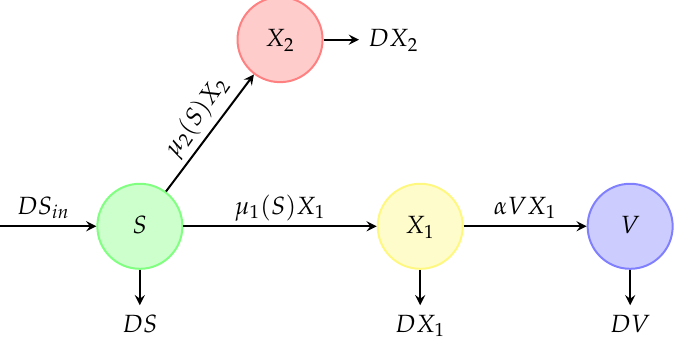
Figure 2. Competition of two species in a chemostat in presence of a one species virus. Circles describe the compartments S , X 1 , X 2 and V and the arrows (and labels) correspond to rates of transition between them.